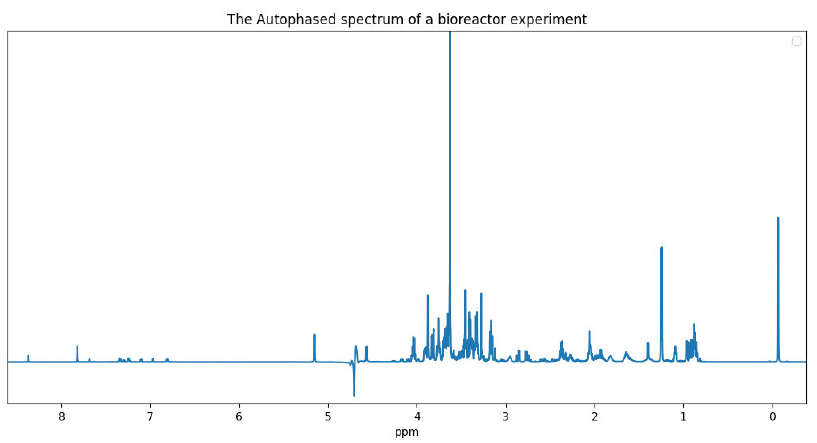
Figure 3. The real part of the autophased spectrum of an mammalian cell bioreactor NMR